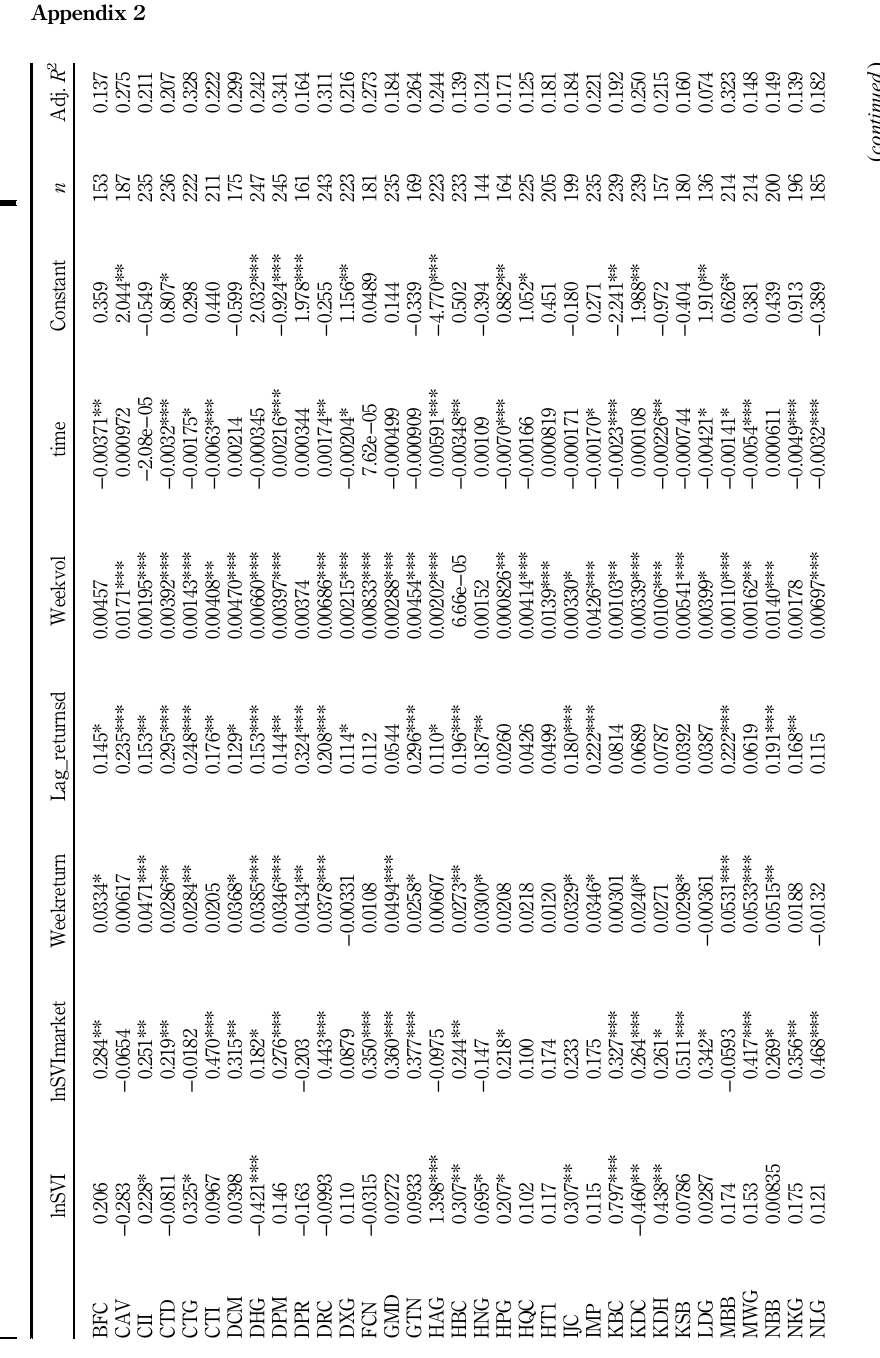
Table AII. Model II